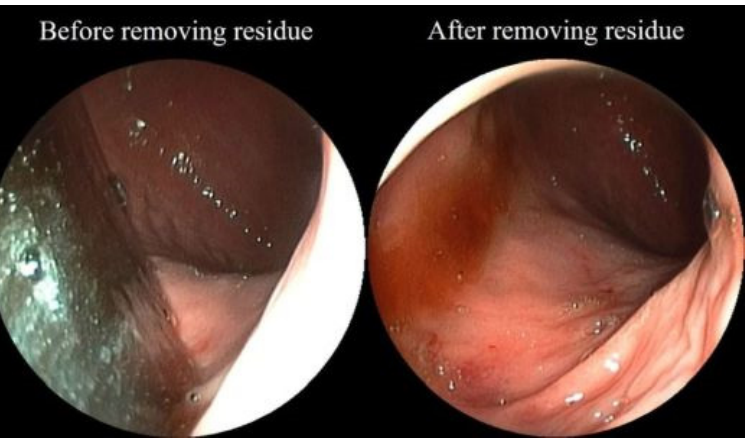
Figure 8. Endoscopic images showing the operation field before (left) and after (right) the applica- tion of the suction method.